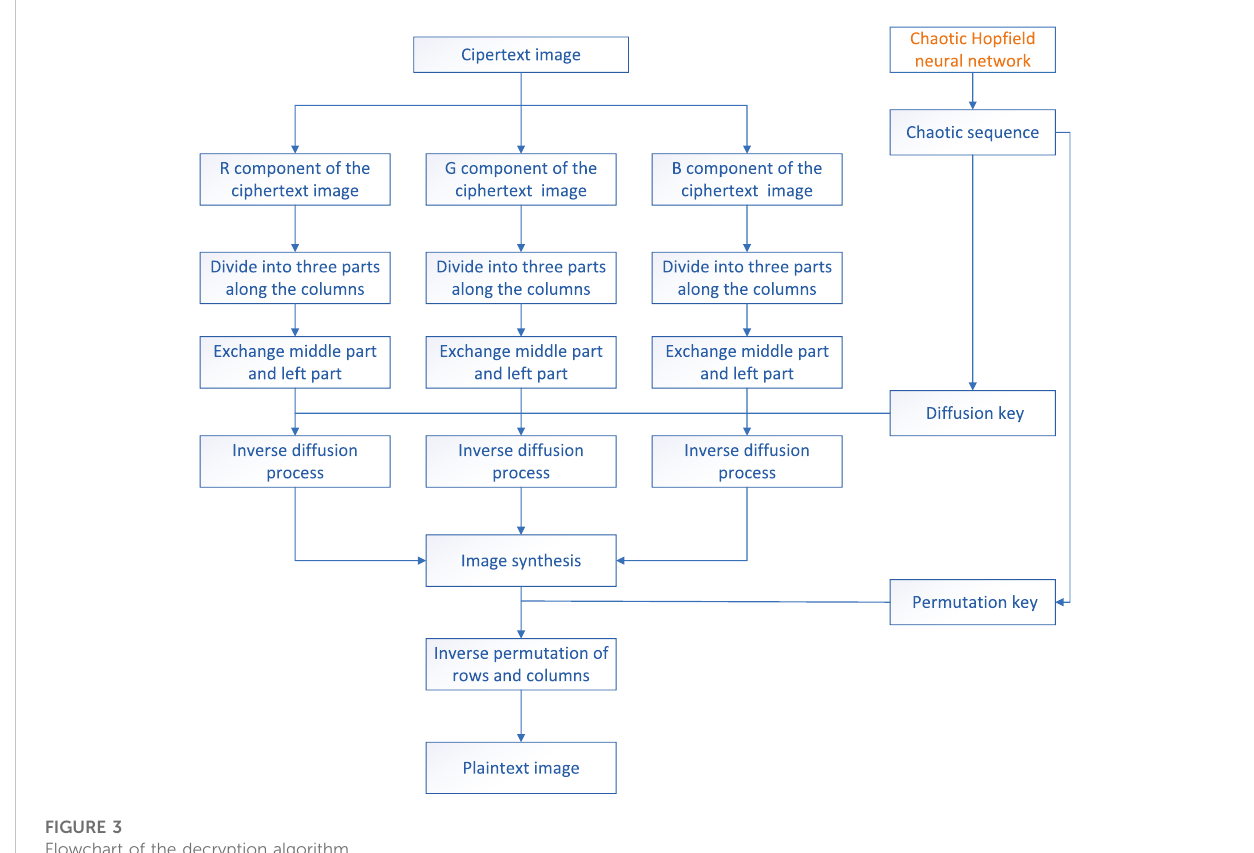
FIGURE 3 Flowchart of the decryption